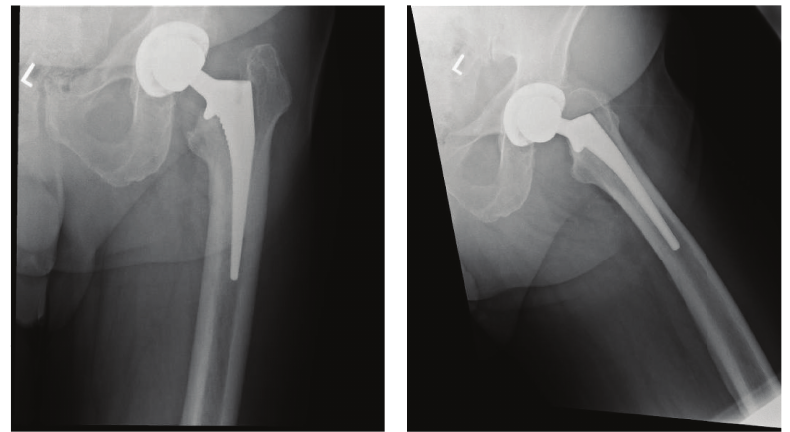
Figure 2: AP and lateral of the primary THA showing good alignment without fracture.